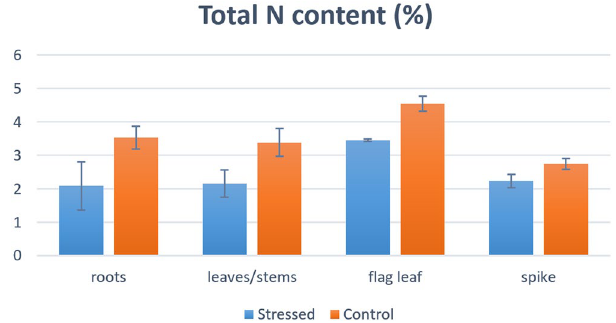
Figure 1. Total nitrogen (N) content detected in four tissues from durum wheat plants grown under standard (control) or N starvation (stressed) conditions. Values represent the N percentage relative to dry matter.